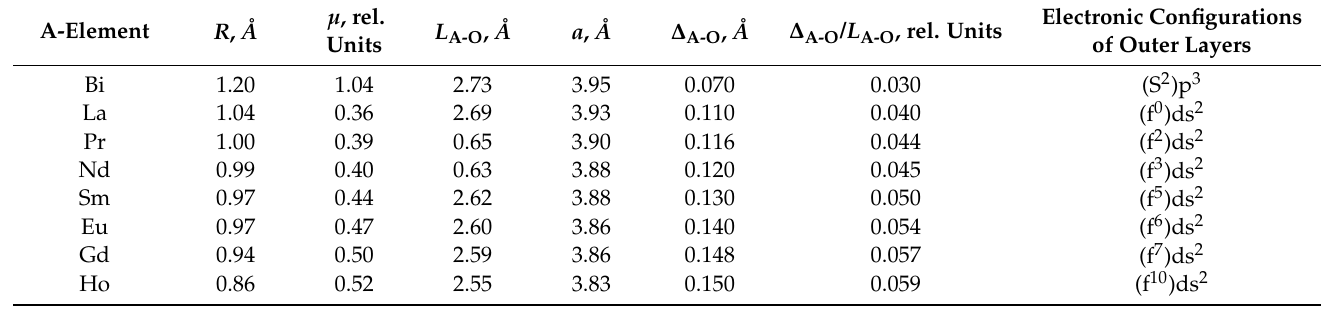
Table 1. Main crystal chemical characteristics of A-elements (A-Bi, La, Pr, Nd, Sm, Eu, Gd, Ho).